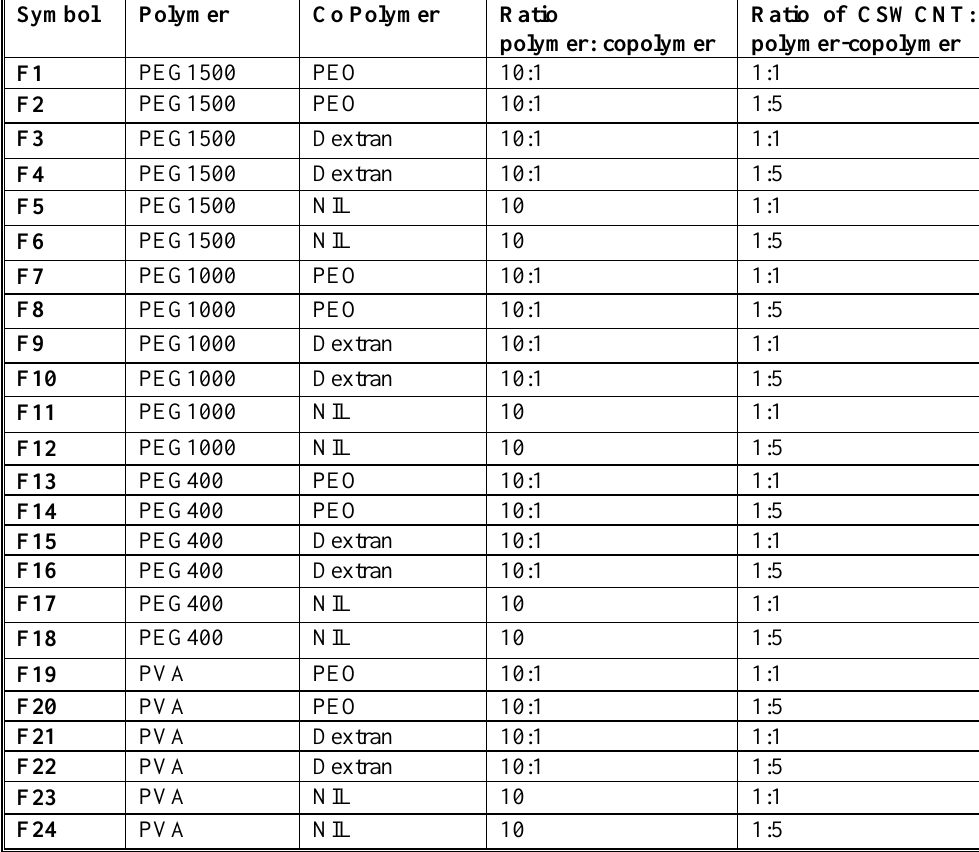
Table (1) Composition of polymer-copolymer used for functionalization of CSWCNT